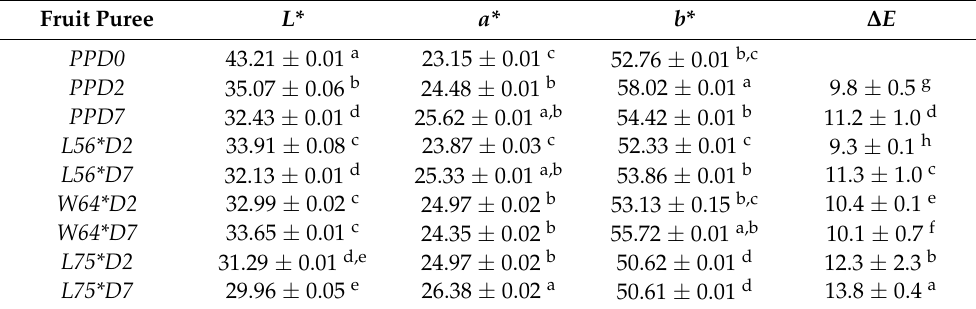
Table 2. Colour characteristics of fermented and non-fermented papaya puree. Fruit